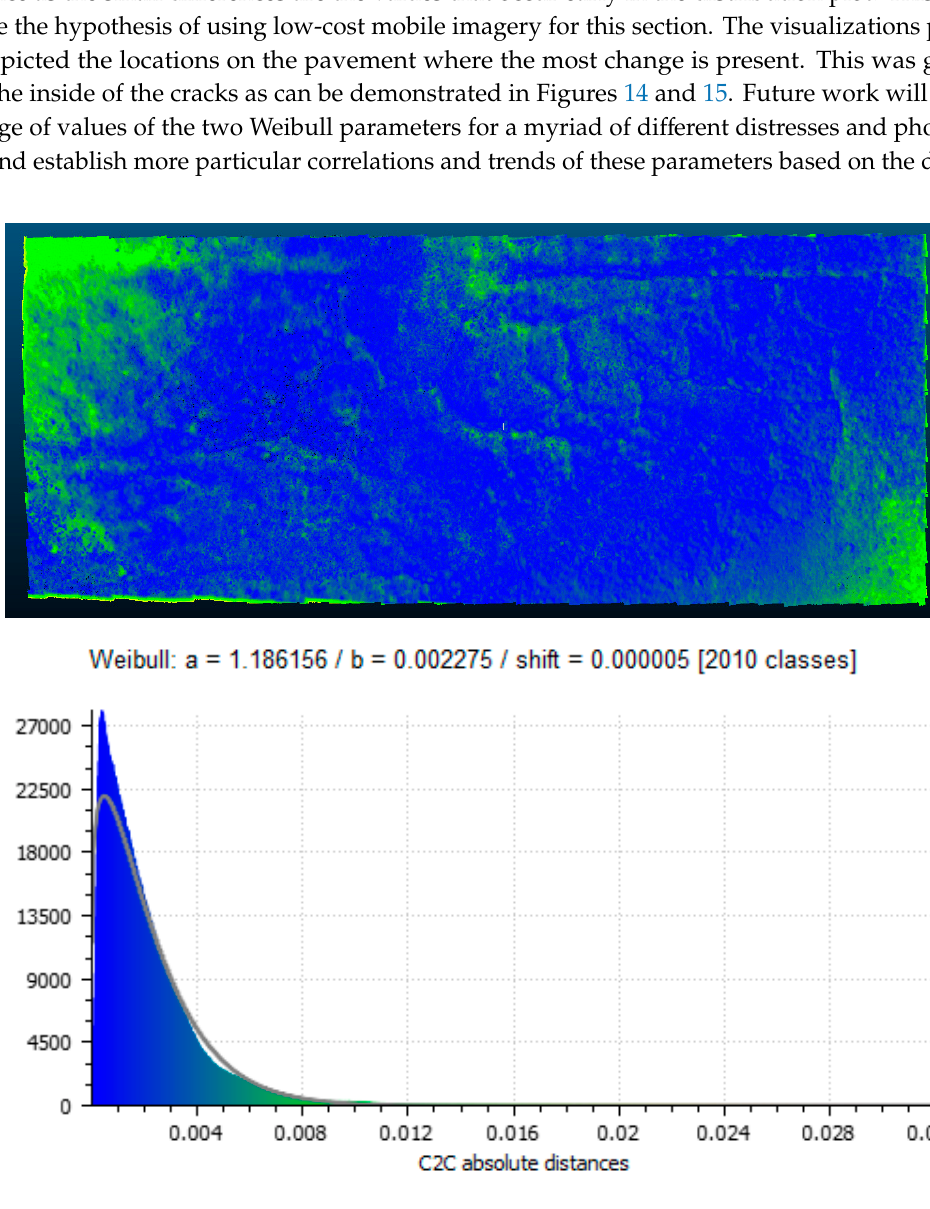
Table 5. Weibull parameters observed from each model comparison for Distressed Section 1.